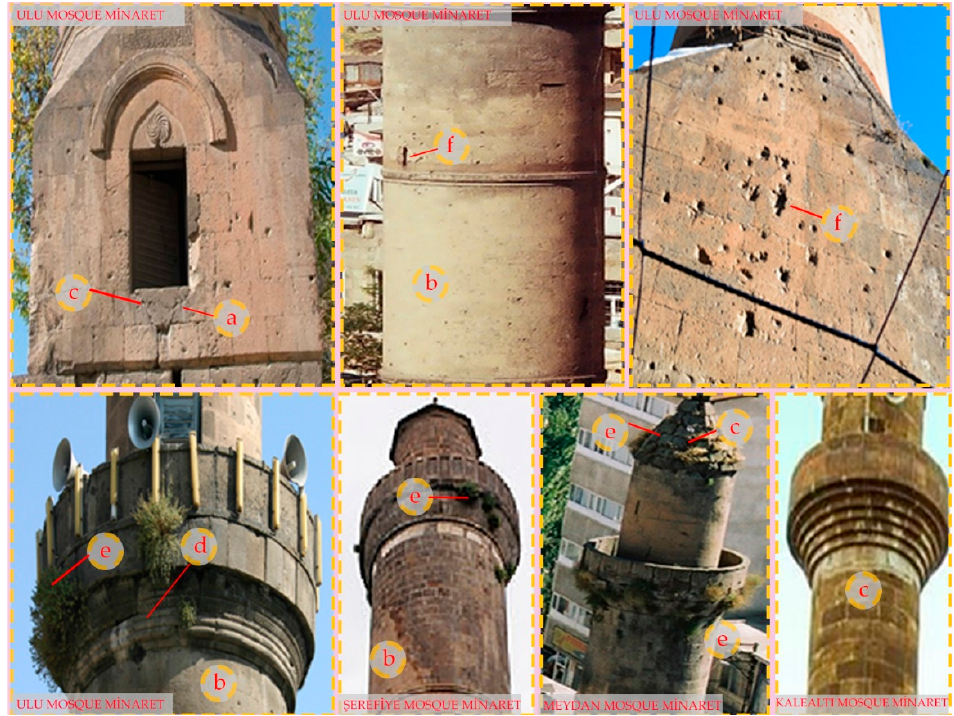
Figure 4. Damages observed in Five Minarets: a. high temperature difference; b. discoloration and color change; c. water effects; d. rupture damage; e. vegetation and f. bullet traces.